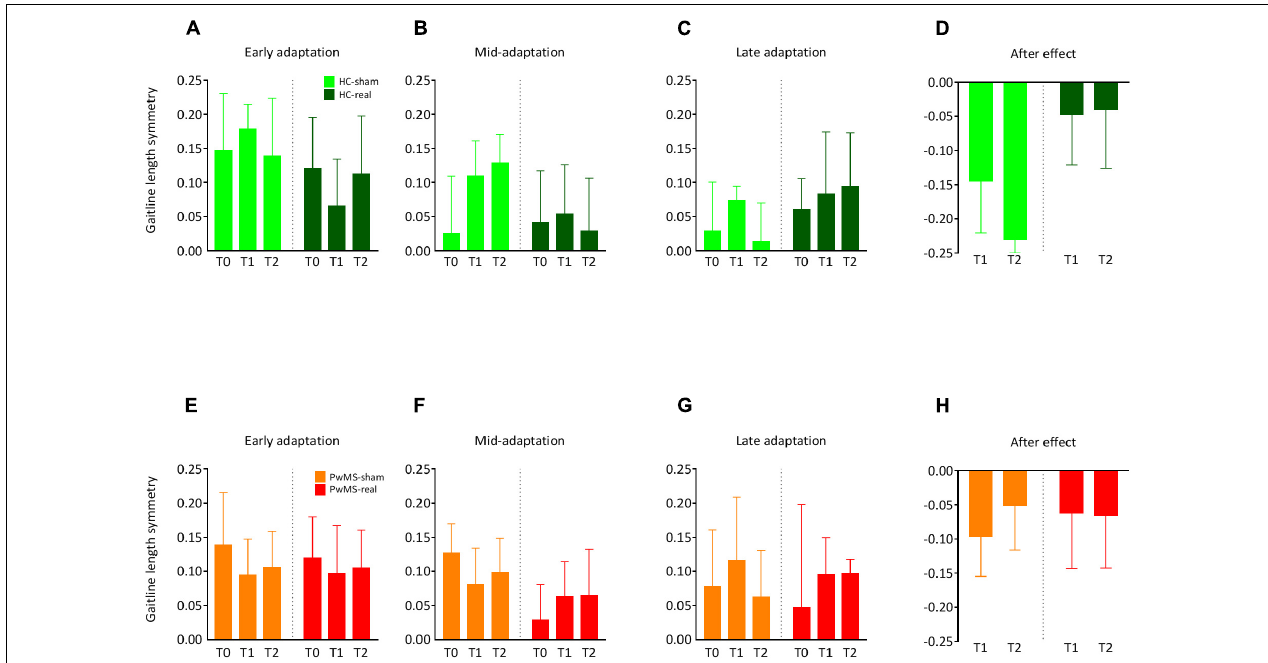
FIGURE 4 | Changes in the symmetry of gaitline length across training phases in experiment 2 (with tDCS): Training on the split-belt treadmill was performed at T0, T1 (24 h after the first trial), and T2 (72 h after the first trial). Cerebellar anodal (real) or sham tDCS was applied ipsilateral to the fast leg immediately after the adaptation phase at T0. The blue color represents data from HC, data obtained from PwMS are red-colored. (A,E) Average gaitline length symmetry in the early adaptation obtained from the first six strides in the adaptation phase for HC and PwMS. (B,F) Average gaitline length symmetry during mid-adaptation obtained from the first 50 strides following early adaptation in the adaptation phase. (C,G) Average gaitline length symmetry during late adaptation obtained from the last six strides in the adaptation phase. (D,H) Average gaitline length symmetry during early postadaptation obtained from the first six strides in the postadaptation phase of the training, only at T1 and T2. Error bars represent the standard error of means ( N HC − sham = 9, N HC − real = 11, N PwMS − sham = 15, N PwMS − real =